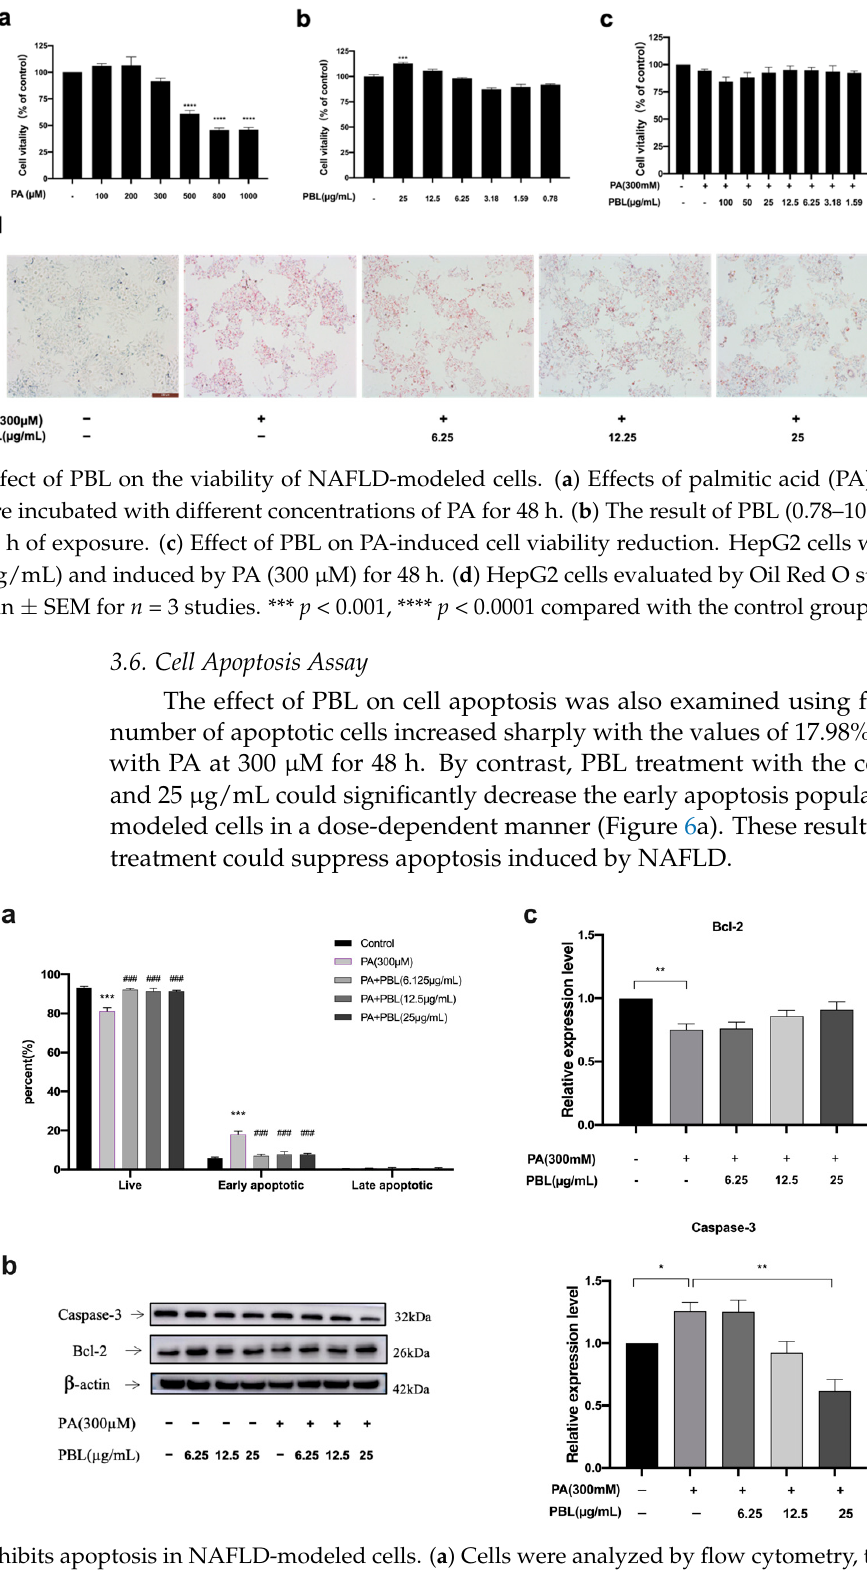
Figure 6. PBL inhibits apoptosis in NAFLD-modeled cells. ( a ) Cells were analyzed by flow cytometry, the percentage of apoptotic cells. The suppression on apoptosis of PBL on NAFLD-modeled cells. The NAFLD-modeled cells were treated with PBL (6.25–25 µg/mL) for 48 h. Data are presented as mean ± SEM ( n = 3). *** p < 0.001 compared with the control group. ### p < 0.01 compared with the PA (300 µM) group. ( b , c ) Effects of PBL on Bcl-2, caspase-3 and protein expression in NAFLD-modeled cells. The data are represented as mean ± SEM ( n = 3). * p < 0.05, ** p < 0.01 compared between the marked groups.